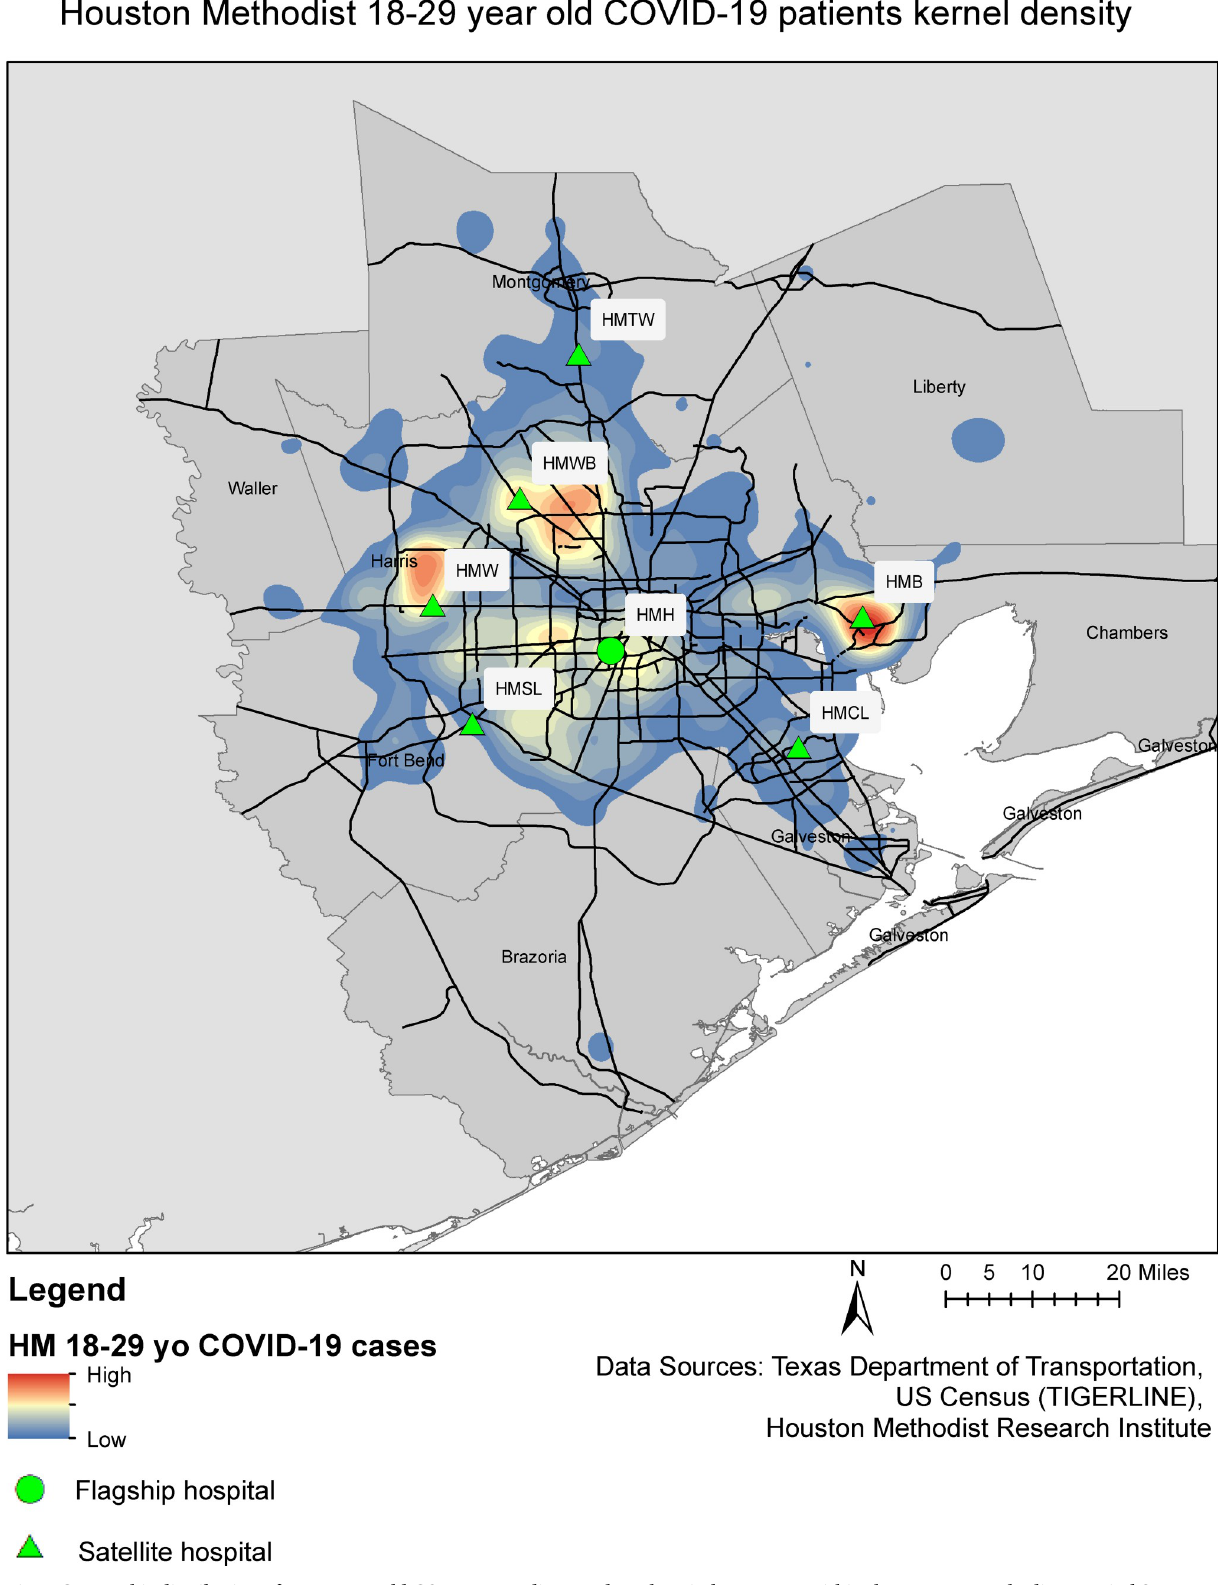
Fig 3. Geographic distribution of 18–29 year-old COVID cases diagnosed at a hospital encounter within the Houston Methodist Hospital System.